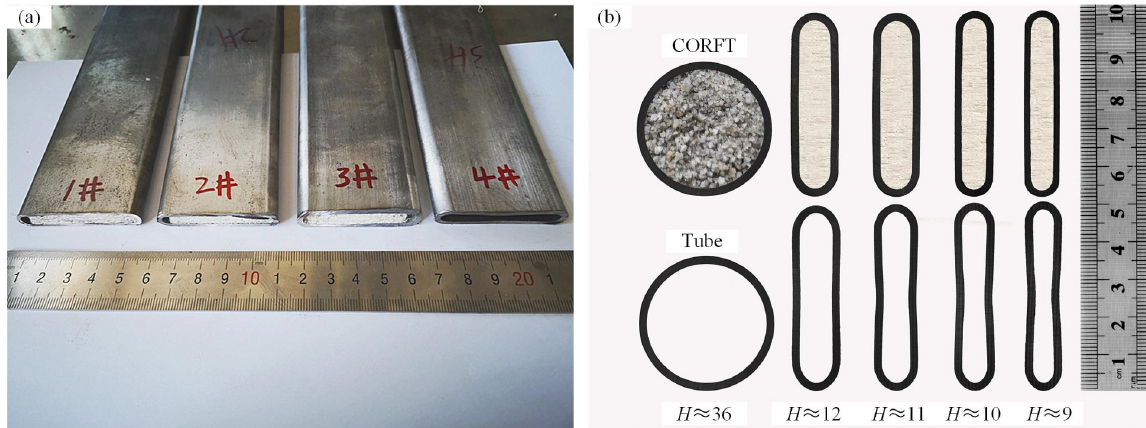
Fig 7. Pictures of the CORFTs and the tube. (a) Products, and (b) scanning image of the section.